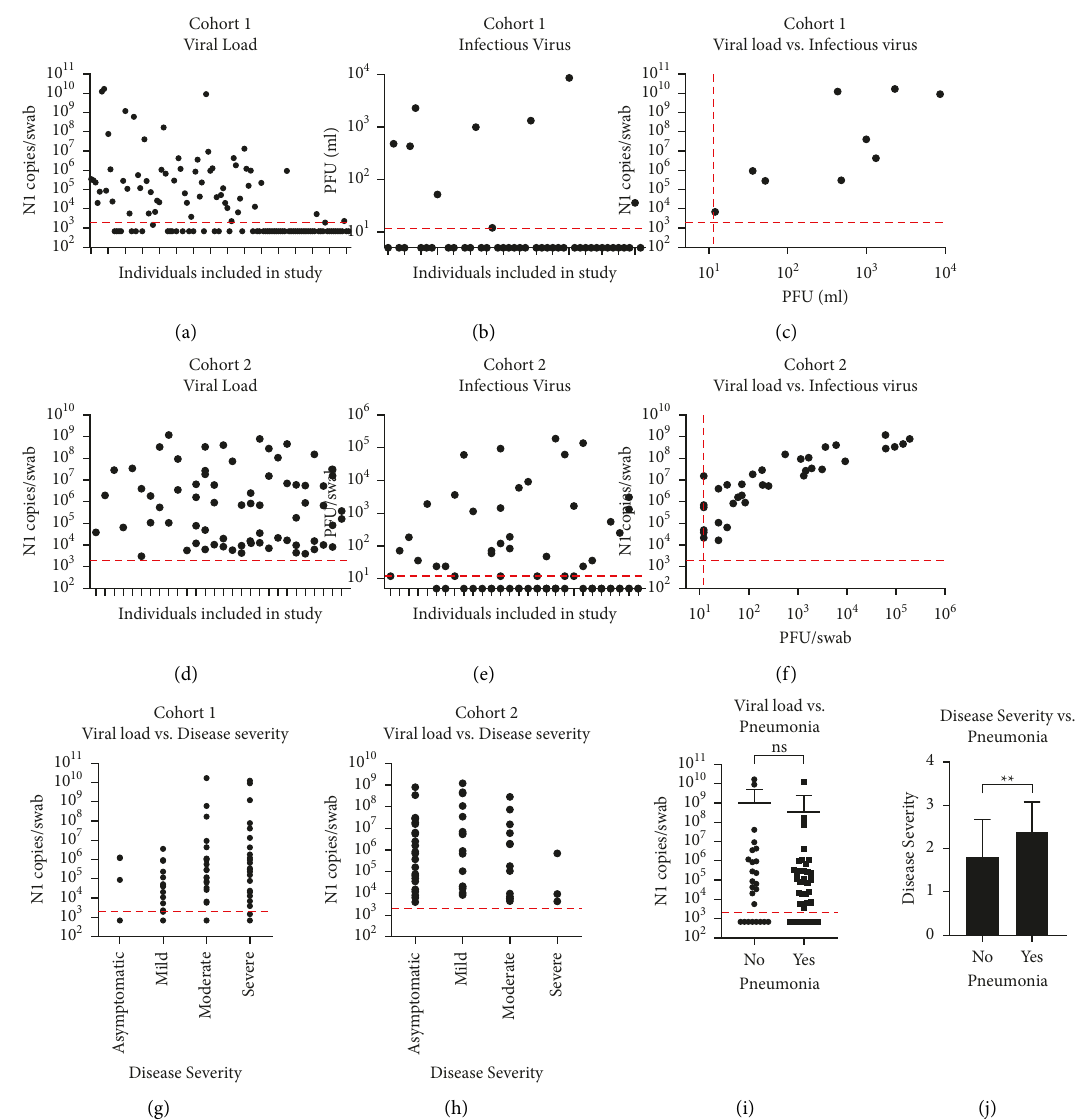
Figure 1: Viral load correlations with infectious viral titer and disease severity. (a, d) Viral loads for cohorts 1 and 2, determined by qRT- PCR as SARS-CoV-2 N1 RNA copies per NP swab. The red dashed line indicates limit of detection at 2,273.5 N1 copies/swab. (b, e) Infectious virus titers for cohorts 1 and 2, determined by plaque assay as plaque-forming units (PFU) per ml. The red dashed line indicates limit of detection at 12PFU/ml. (c, f) Correlation between viral load and infectious virus titer for cohorts 1 and 2. Statistical correlation was determined by the Spearman nonparametric test. (g, h) Correlation between viral loads and COVID-19 severity for cohorts 1 and 2. Statistical correlation was determined by the Spearman nonparametric test. The red dashed line indicates the limit of detection. (i, j) Cohort 1 viral load and disease severity in patients with pneumonia compared to patients without pneumonia. Statistical association was determined p by the Mann–Whitney nonparametric test ( 0 . 01). The red dashed line indicates limit of ∗∗ <